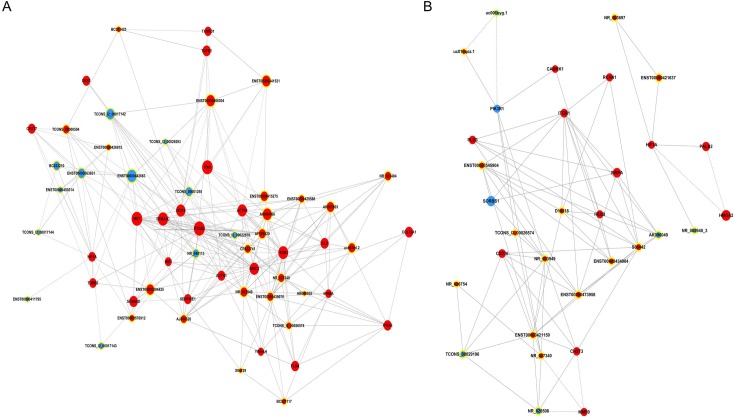
LncRNA-mRNA expression correlation network analysis of core mRNAs and their correlated lncRNAs in advanced LSCC.In the network, nodes represent mRNAs, nodes with yellow rings represent lncRNAs, and the size of the node’s area represents the value of betweenness centrality. Red color indicates up-regulation and blue indicates down-regulation relative to adjacent non-neoplastic tissues. The lines between nodes indicate a correlative relationship within the group, solid line represents positive correlation, and the dotted line represents negative correlation. (A) LncRNA-mRNA expression correlation network of core mRNAs in cancer tissues. (B) LncRNA-mRNA expression correlation network of core mRNAs in adjacent non-neoplastic tissues.